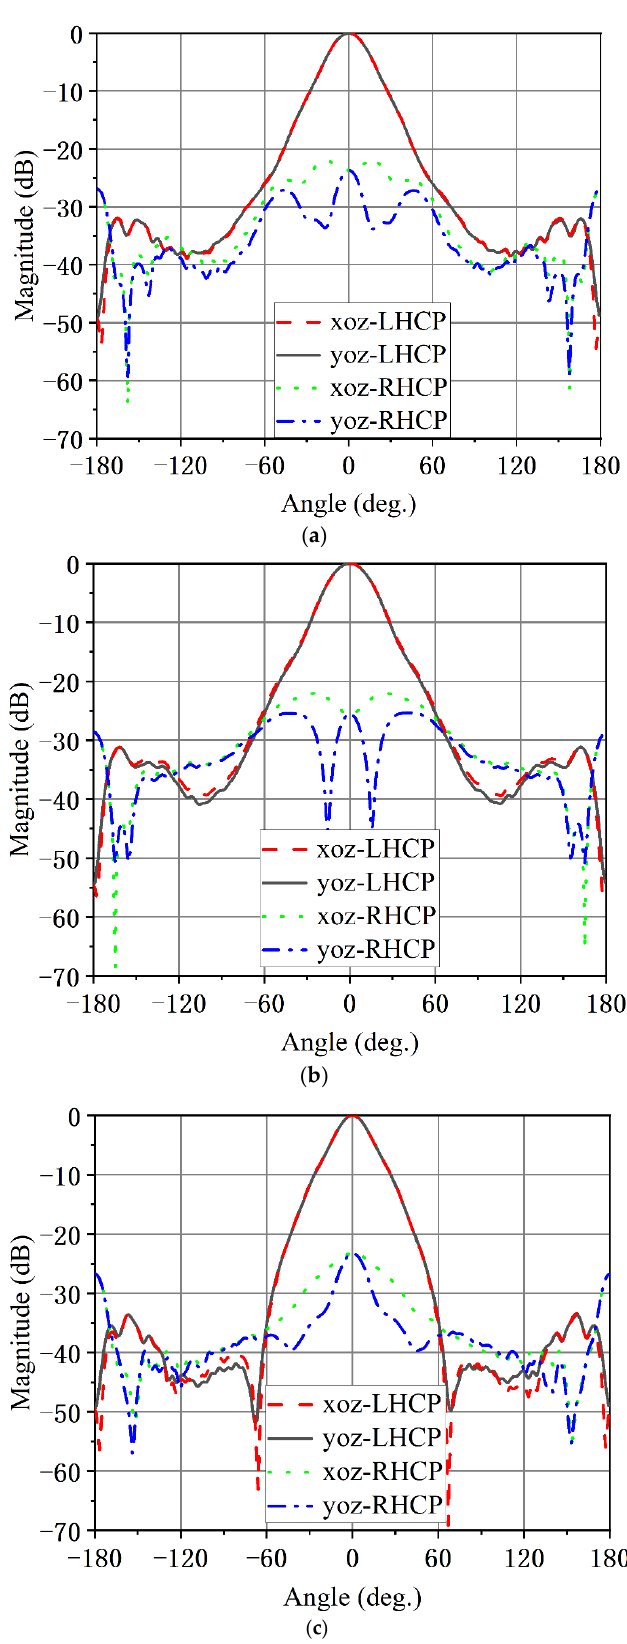
Figure 19. Simulated radiation patterns of the circular polarized horn antenna at ( a ) 20 GHz, ( b ) 24 GHz and ( c ) 30 GHz. ( b ) 24 GHz and ( c ) 30